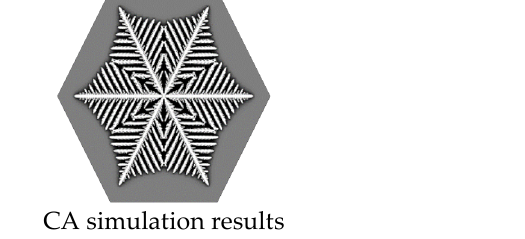
Figure 11. CA and PF simulate classic snow pattern 1.